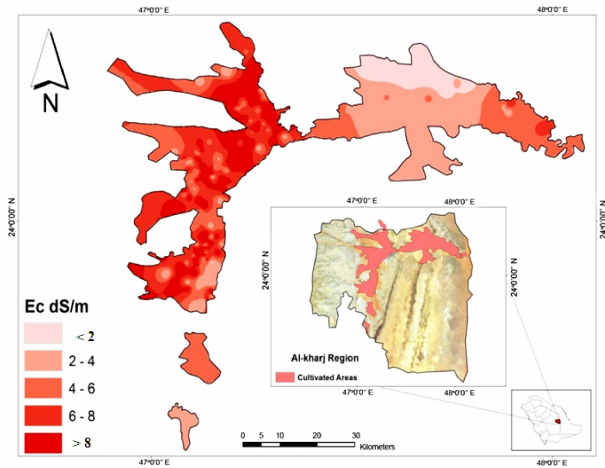
Figure 9. Interpolation of groundwater